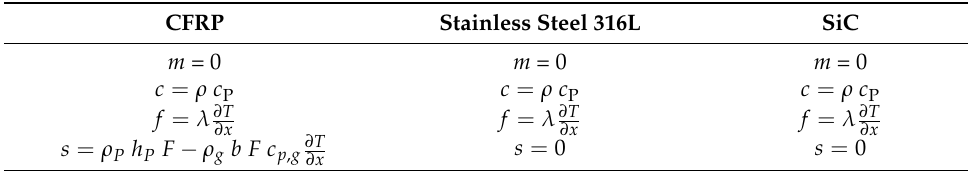
Table 2. Parameters m , c , f , s for CFRP, stainless steel 316L and SiC.